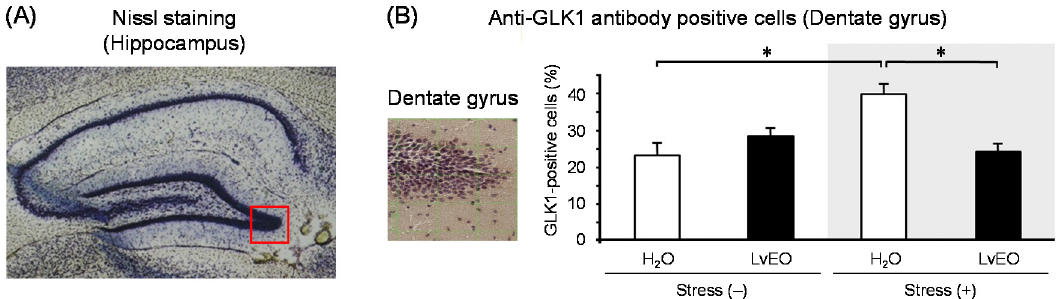
Figure 4. The effects of lavender on protein expression levels in the mouse brain. After water immersion stress, brain sections of mice inhaled with distilled water or LvEO were stained immunohistochemically with anti-galactokinase 1 (GLK1) antibody. ( A ): Nissl-stained mouse brain frontal section at the level of the hippocampus. ( B ): Expression of GLK1 positive cells in the dentate gyrus, inside the photo square indicated in ( A ). The results are expressed as the ratio of the number of GLK1 positive cells to that of Nissl-stained cells (%), and are means ± SEM (n = 4). * p < 0.05 (Tukey–Kramer’s HSD test). This figure is modified based on the original figure published [90].